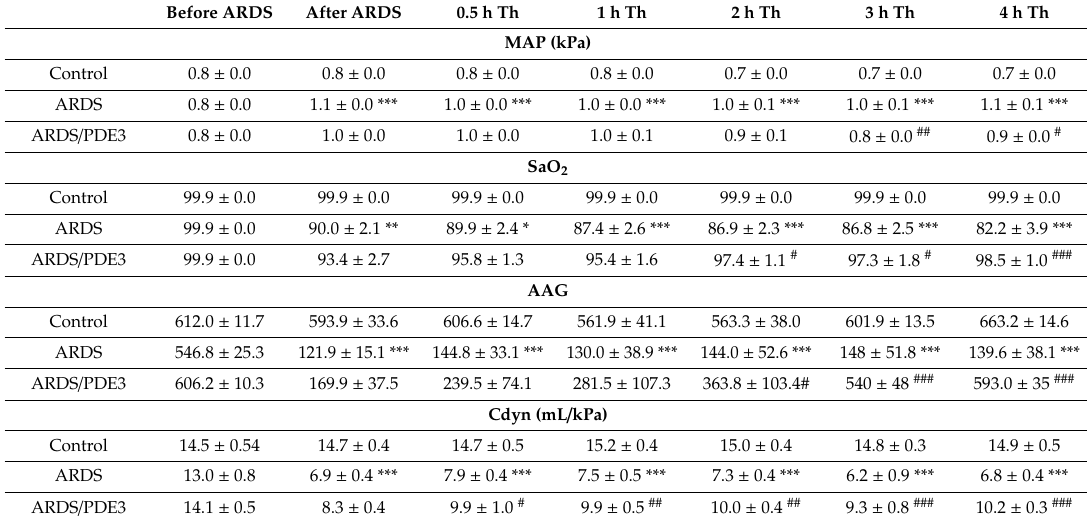
Table 2. Mean airway pressure (MAP), arterial oxygen saturation (SaO 2 ), alveolar–arterial gradient (AAG), and dynamic lung–thorax compliance (Cdyn) before (basal value, BV) and after lung lavage (ARDS) and within 4 h after administration of the therapy (Th) in healthy ventilated and non-treated animals (Control group), in non-treated animals with ARDS (ARDS group) and in animals with ARDS treated with olprinone (ARDS / PDE3 group). Statistical comparisons: for ARDS vs. Control * p < 0.05, ** p < 0.01, *** p < 0.001; for ARDS / PDE3 vs. ARDS # p < 0.05, ## p < 0.01, ### p < 0.001. Data are presented as means ± SEM. Before ARDS After ARDS 0.5 h Th 1 h Th MAP